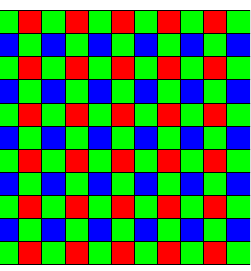
Fig. 2.— Part of a Bayer mask pattern: an array of filters in- stalled in front of detector pixels to enable the quick creation of a colour